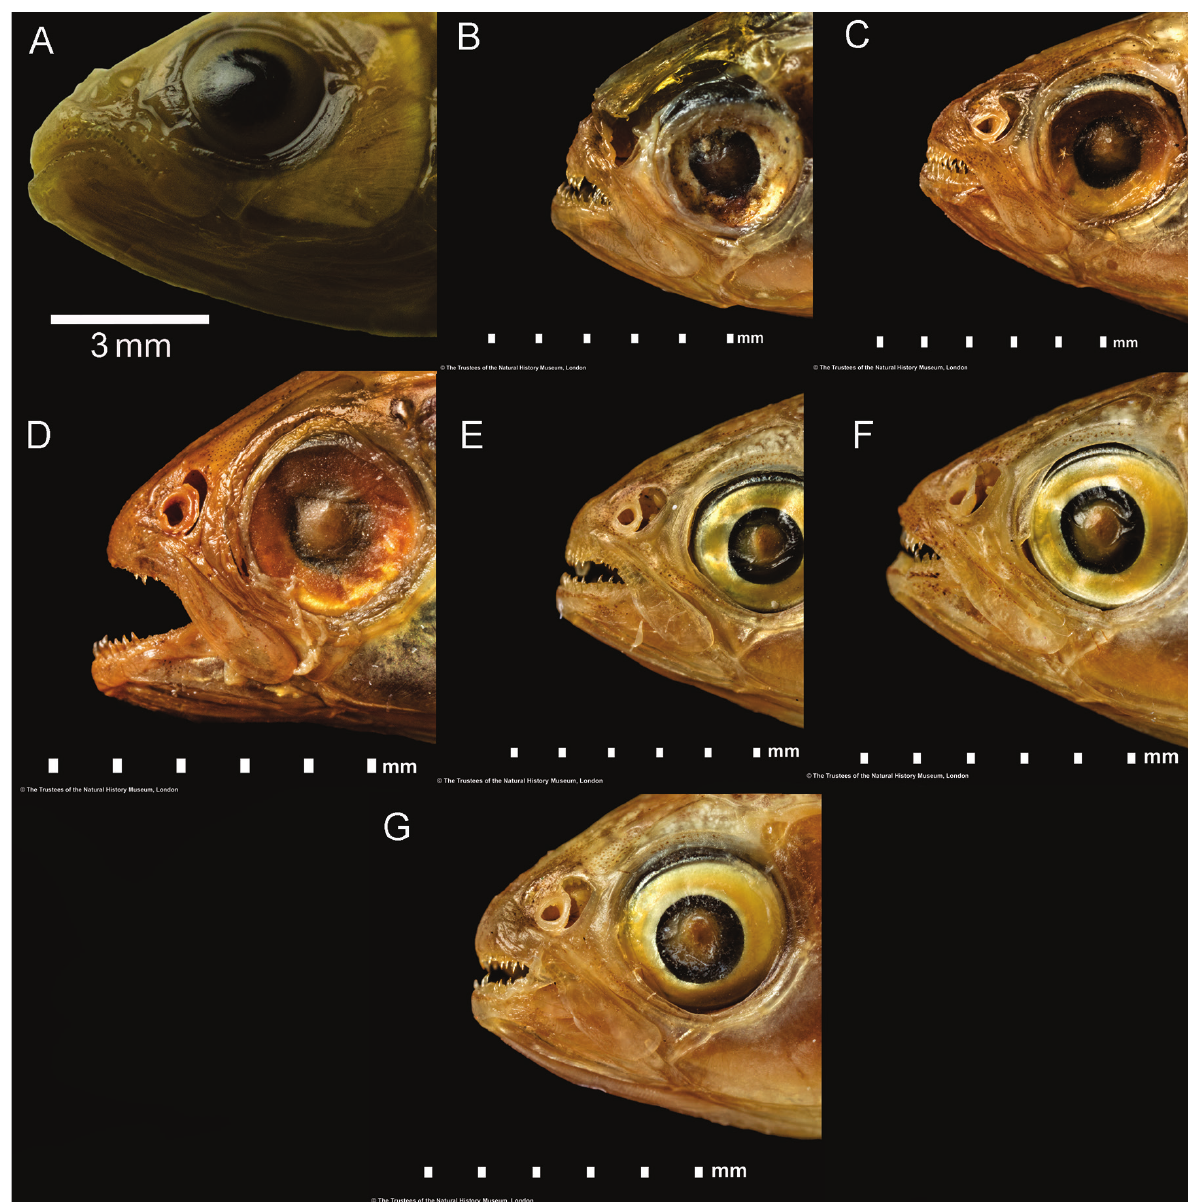
Figure 4. Maxillary teeth of: A, Holotype of Aphyocharax avary : ANSP 39217; B, Syntype of Aphyocharax pusillus : BMNH1867.6.12.46; C, D; Syntypes of Aphyocharax pusillus : BMNH 1867.6.13.58-59; E, Lectotype of Chirodon alburnus : BMNH 1869.5.21.10; F, G, two of the three paralectotypes of Chirodon alburnus (head damaged in a third): BMNH 1869.5.21.11-13. A, Photographed by Axel Katz; and B-G, Photographed by Kevin